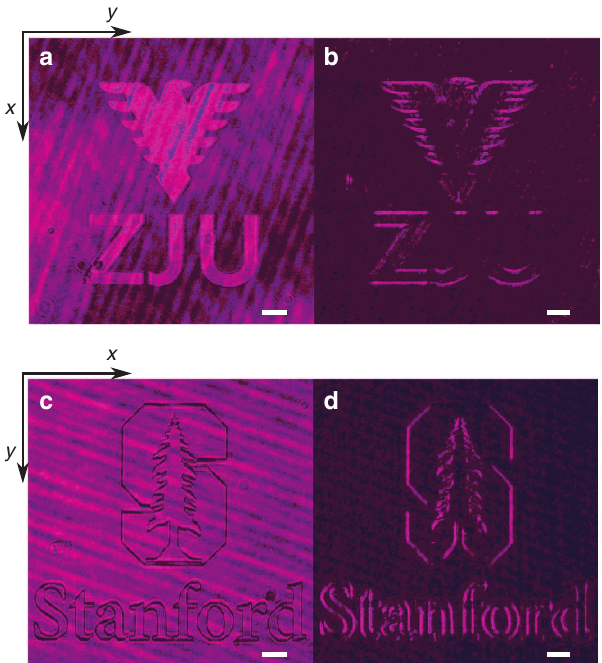
Figure 4 | Edge detection for changes in either amplitude or phase. ( a ) Incident image consisting of the ZJU eagle logo and letters with amplitude modulation, where the inside and the outside of the letters and the eagle have different intensities. ( b ) Reflected intensity image corresponding to a . ( c ) Incident image consisting of the Stanford tree logo and letters generated with phase modulation, where the inside and the outside of the letters and the logo have different phases but the same intensity. ( d ) Reflected intensity image corresponding to c . The white bars correspond to the length of 100 m